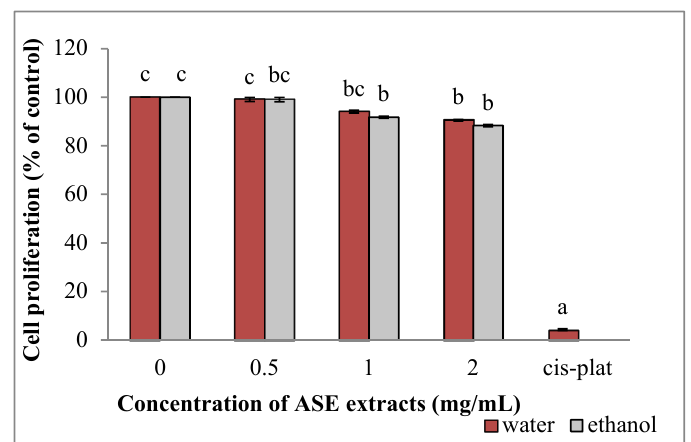
Figure 1. Effect of ASE crude extracts on HUVEC cell proliferation (untreated group: concentration = 0). Data are expressed as mean ± SD, n = 3. Bars marked by unlike letters within a group are significantly different at p < 0.05, according to Duncan’s Multiple Range Test (DMRT).